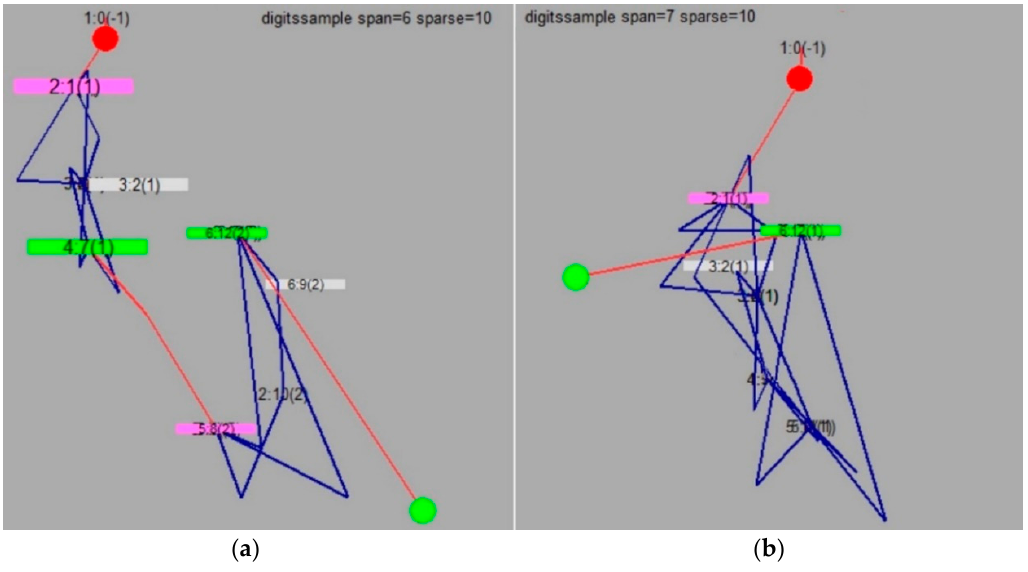
Figure 3. TS employed for the widths ( W ) of 6 and 7 (the unit of W is a week). ( a ) is for W = 6, (b) for W = 7. The overlapping letters are visualized as they are in order to show tokens revisited multiple times.